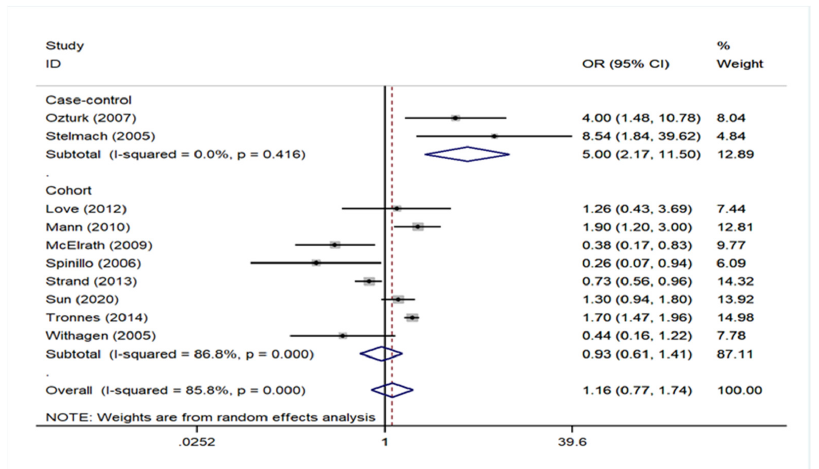
Figure 3. Forest plot describing the association between preeclampsia and cerebral palsy based on the subgroup analysis of studies depending on study design.